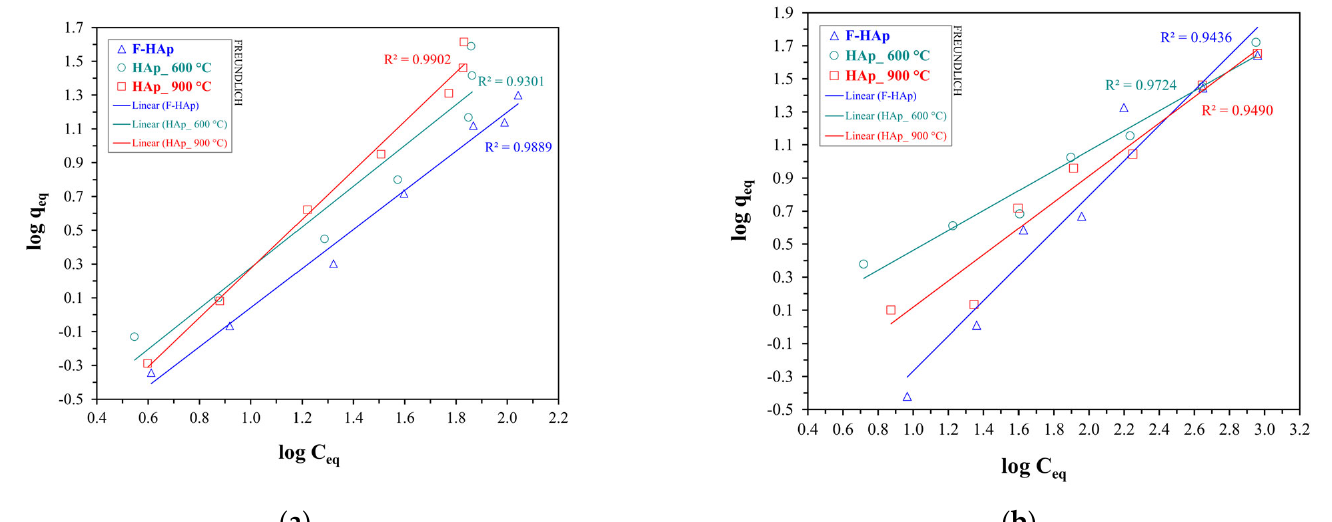
Figure 11. Linear fitting plots of Freundlich isotherm model for ( a ) atrazine and ( b ) cobalt adsorp ‐ tion.